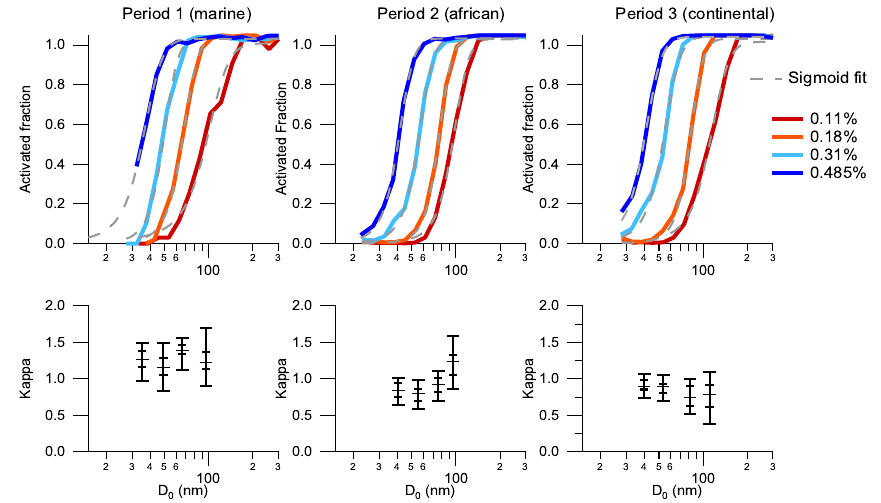
Fig. 7. Averaged CCN data and derived κ values for the 3 study periods. The upper panels show the averaged CCN activation spectra at the set point supersaturations (0.11%, 0.18%, 0.31% and 0.485%). The sigmoid fits for each activation spectrum are overlaid (dash grey lines). The lower panels show the κ values derived from the D 50 at each set supersaturation. The error bars show the range of κ values in the 10th, 25th, 75th and 90th percentiles.